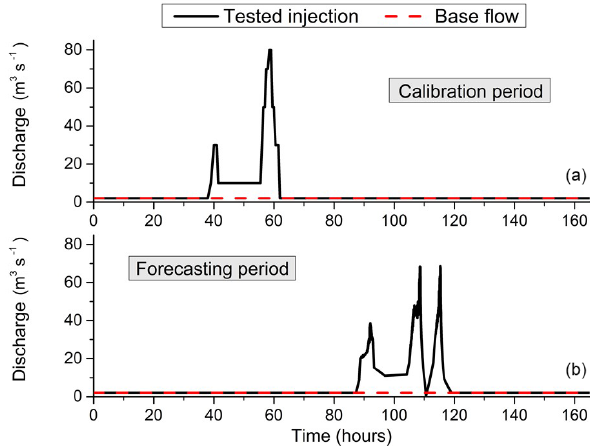
Figure 3. Evolution over time of flow rates injected in the new artifi- cial channel feeding Rohrschollen Island during the period selected for calibrating the integrated hydrological model (a) and the period chosen as a validation (forecasting) exercise (b)